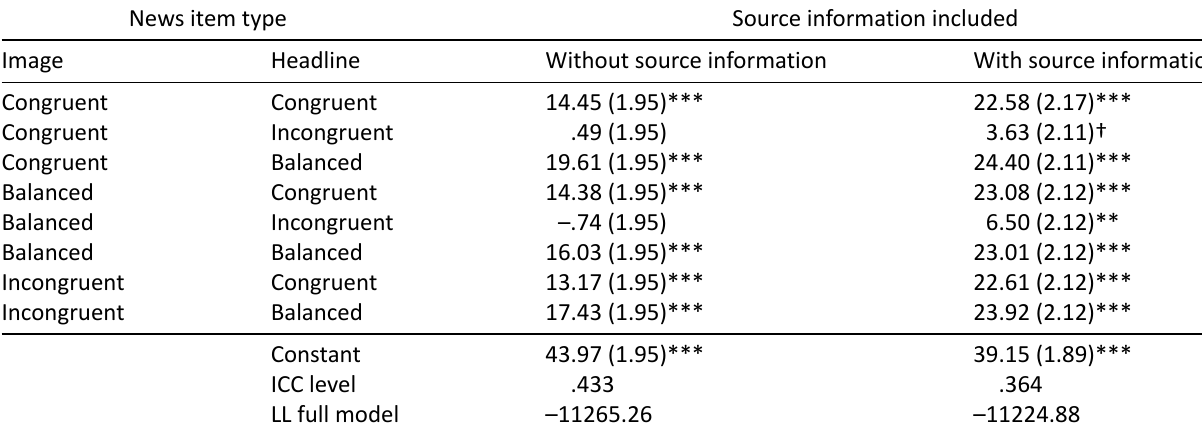
Table A3. Gun control context, multilevel models explaining peoples’ likelihood of viewing a news item, source and no source.